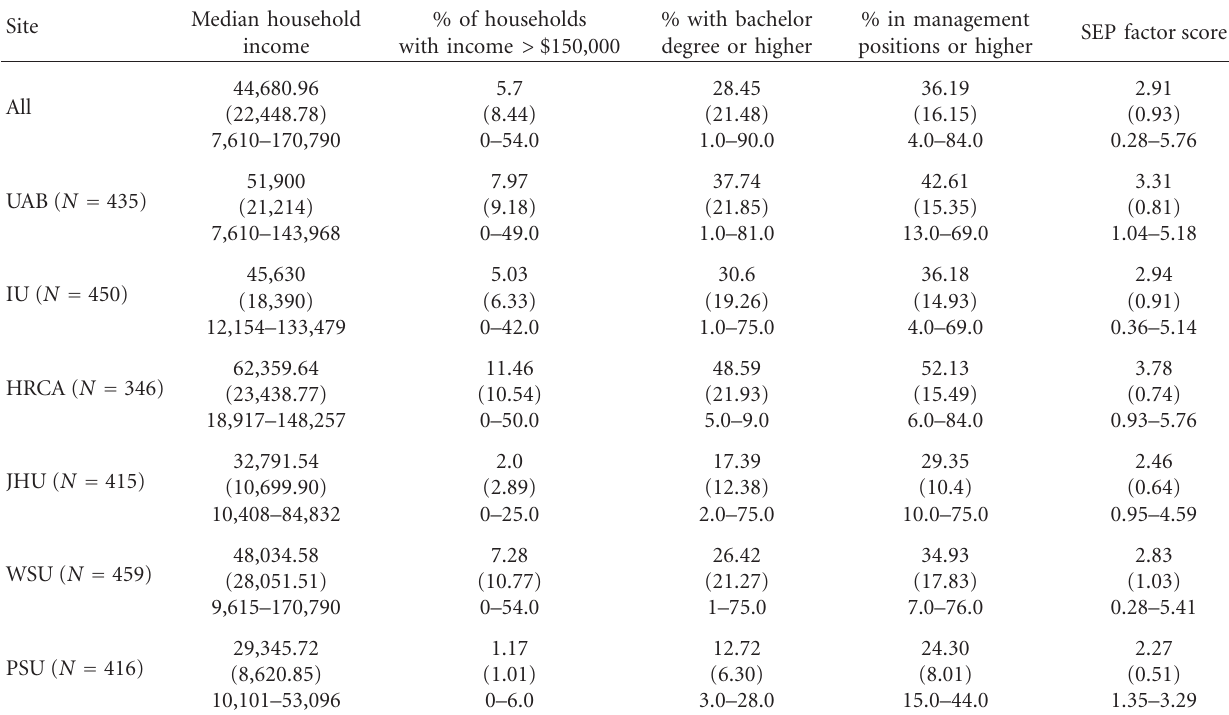
Table 2: Mean, (standard deviation), and range of SEP indicators and factor scores for the overall study sample and by catchment